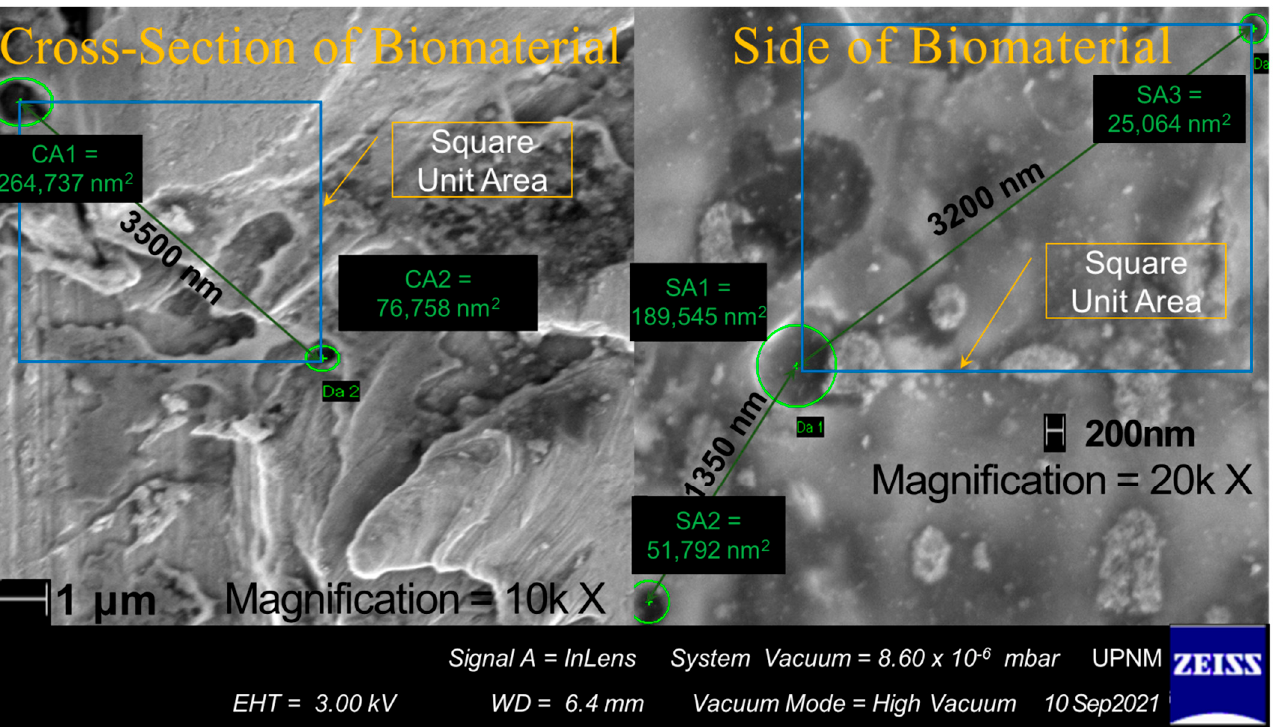
Figure 6. Pore space length and area in cross-section and side of biomaterial from various magnifications. Table 2. Summary of average pore area, surface unit area and porosity. Code